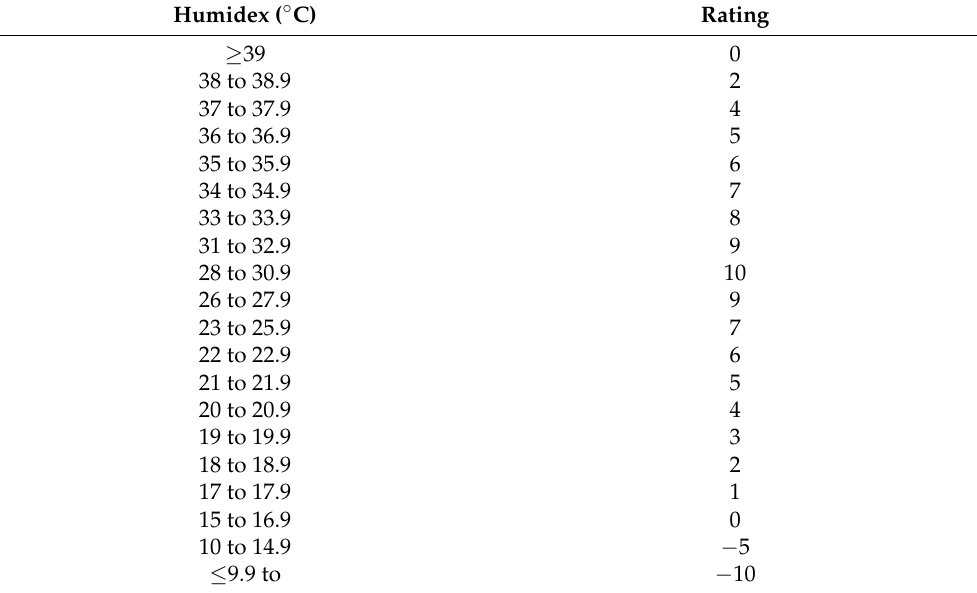
Table A3. Thermal comfort facet rating values.